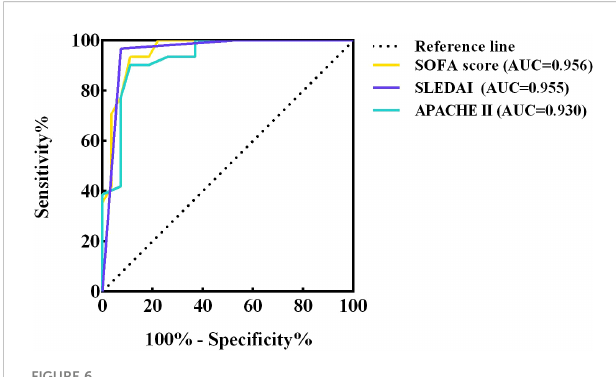
FIGURE 6 ROC curves of SOFA score, SLEDAI and APACHE II. ROC, receiver operating characteristic; AUC, area under curve ROC; CI, con fi dence interval; SOFA, sequential organ failure assessment; SLEDAI, systemic lupus erythematosus disease activity index; APACHE, acute physiology and chronic health